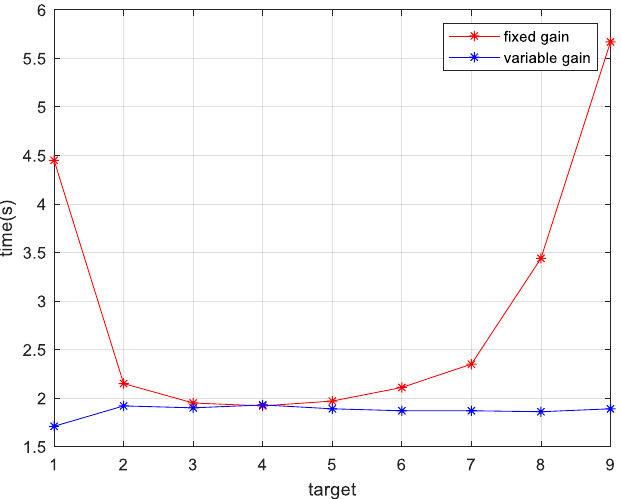
Figure 14. Dynamic response time distribution of IBCLT of nine different targets.